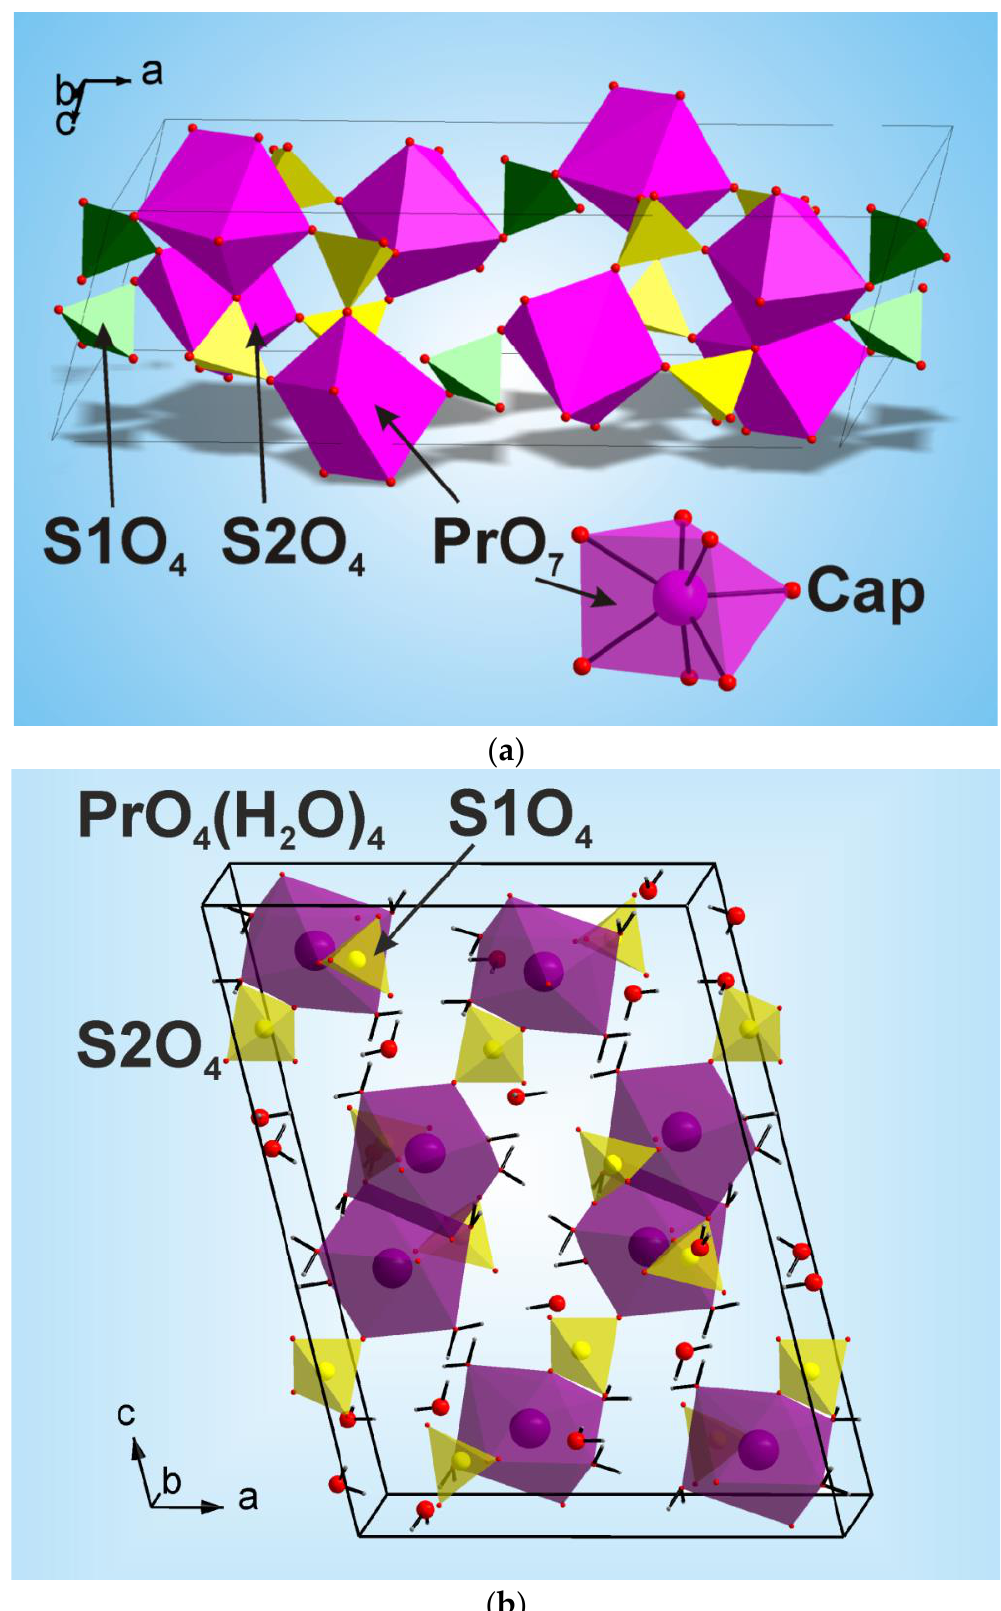
Figure 2. Crystal structures of ( a ) Pr 2 (SO 4 ) 3 and ( b ) Pr 2 (SO 4 ) 3 · 8H 2 O. The unit cell is outlined. Lone atoms are omitted for clarity.